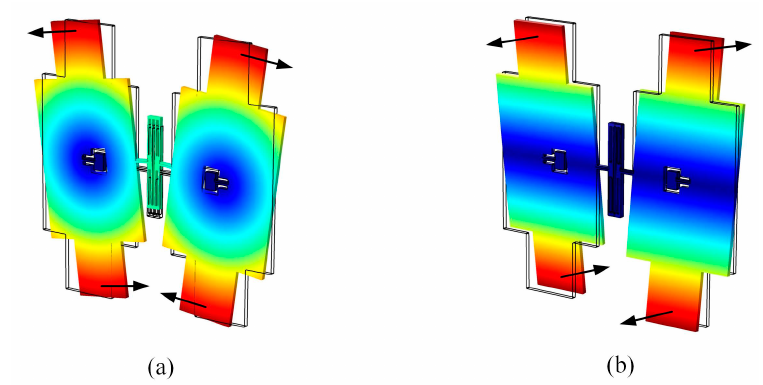
Figure 2. The operating modes of the BFVG: ( a ) The drive mode; ( b ) the sense mode.